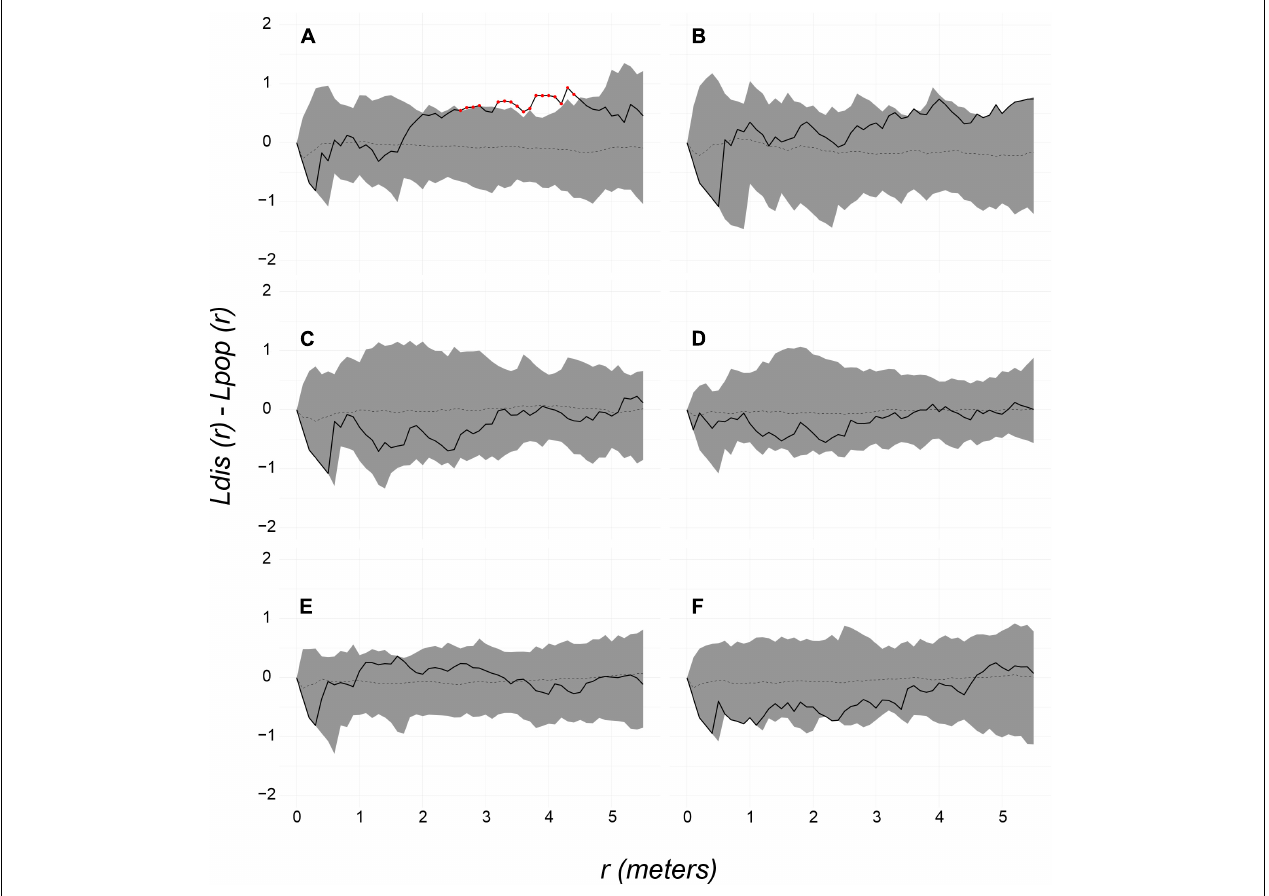
FIGURE 8 | Random labeling test for the newly diseased colonies at Picudas site: (A) Aug 22 to Oct 15, (B) Oct 26, (C) Nov 14, and (D) Nov 27 of 2018, (E) Jan 29, and (F) March 18 to June 24 of 2019. In most tests, the spatial pattern of the survey sample is random (solid line is within the 95% shaded confidence envelope and p = 0.45). Exceptions in A at 2.5–4.5 m scale where the pattern was significantly clustered (pattern above the confidence envelope and p =